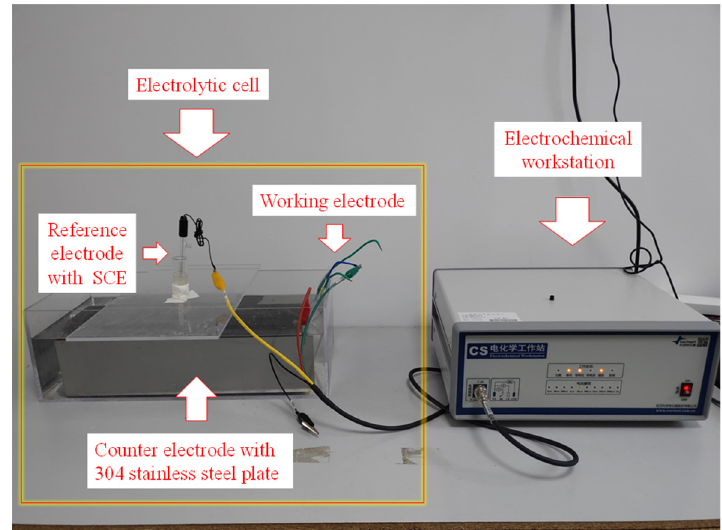
Figure 6. Electrochemical experimental setup.